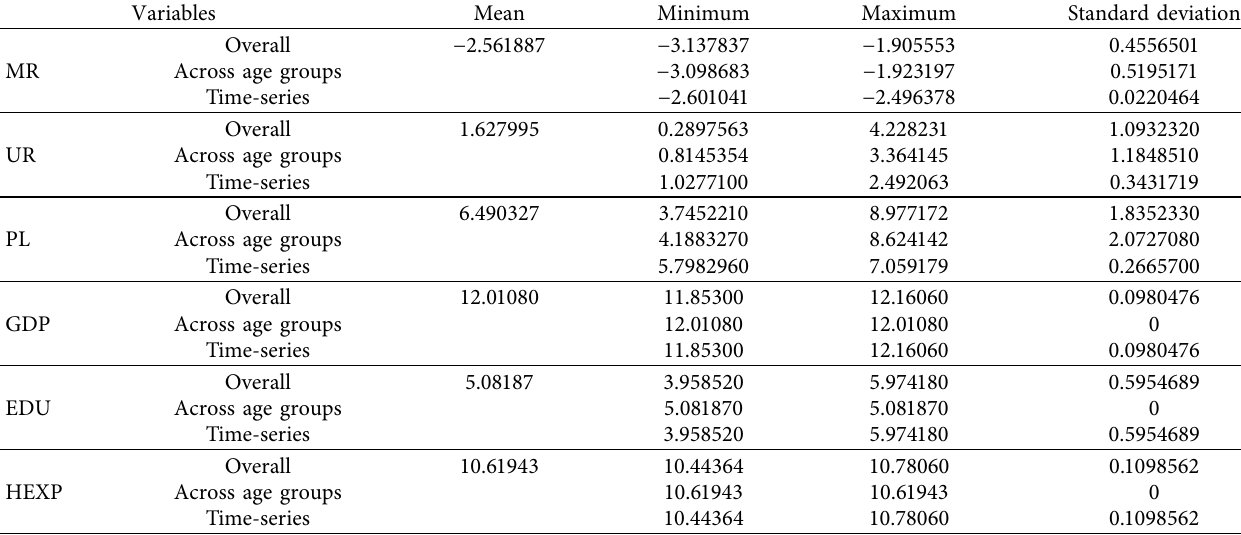
Table 1: Statistical descriptive of variables.